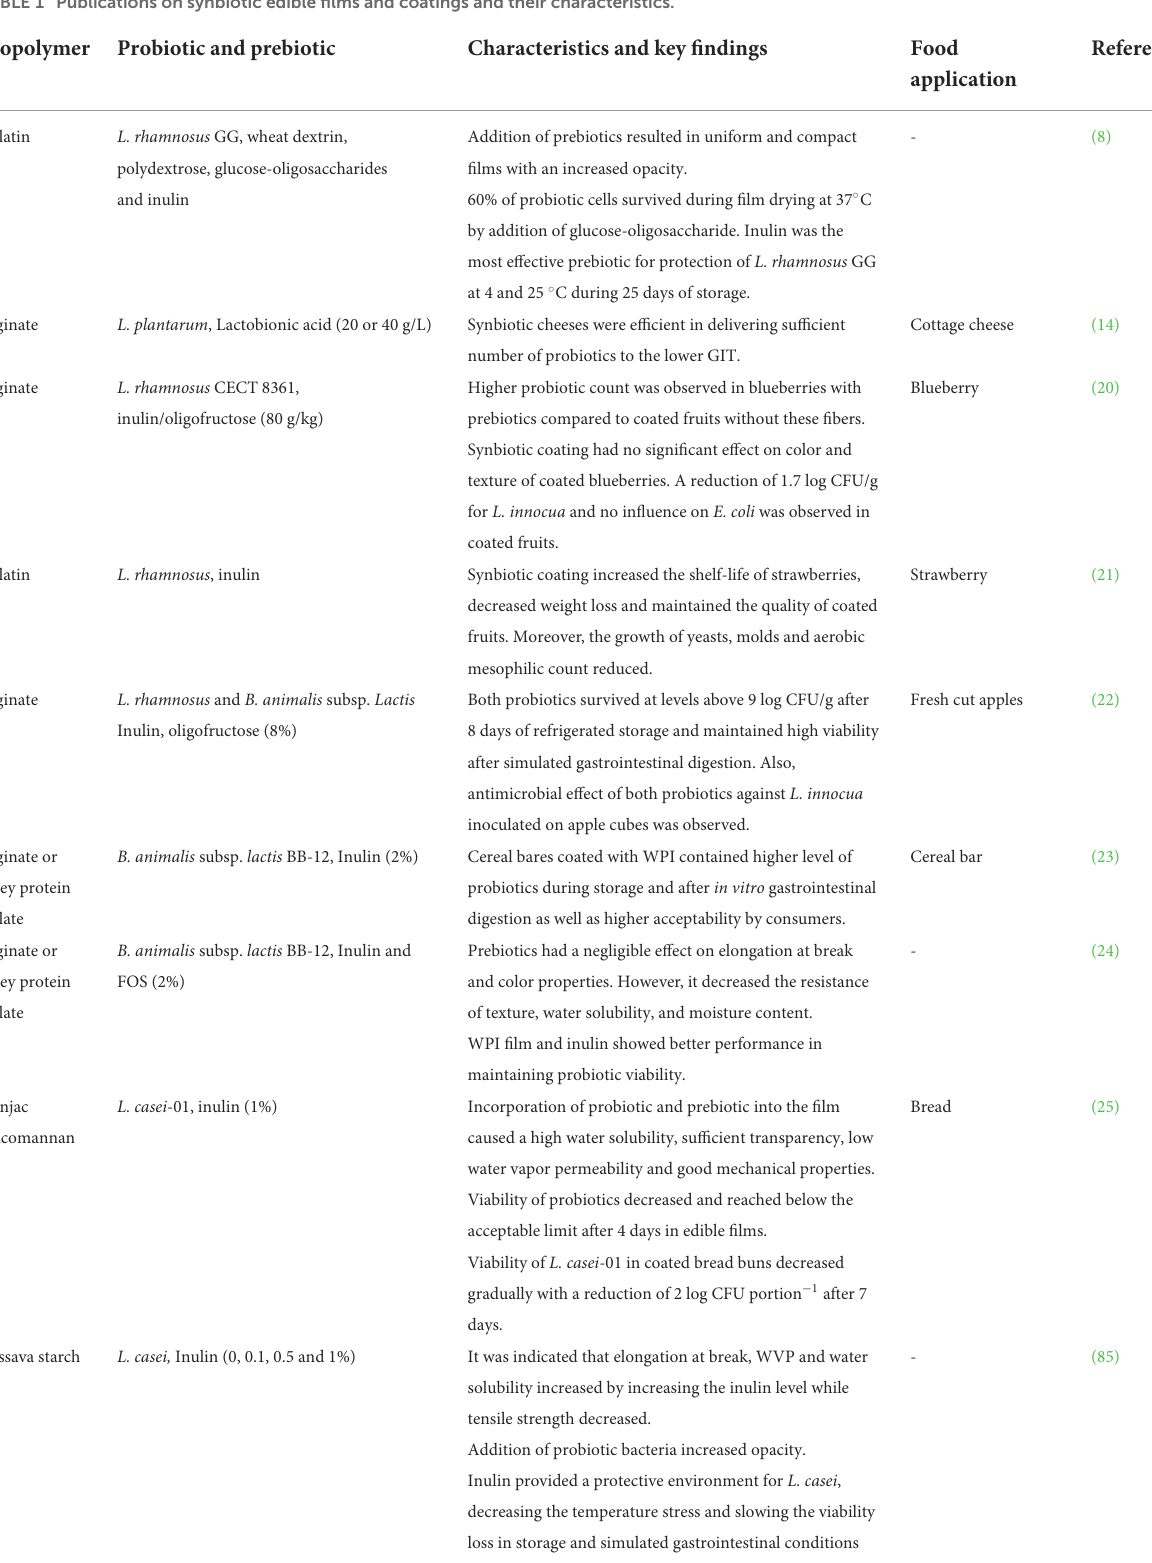
TABLE 1 Publications on synbiotic edible films and coatings and their